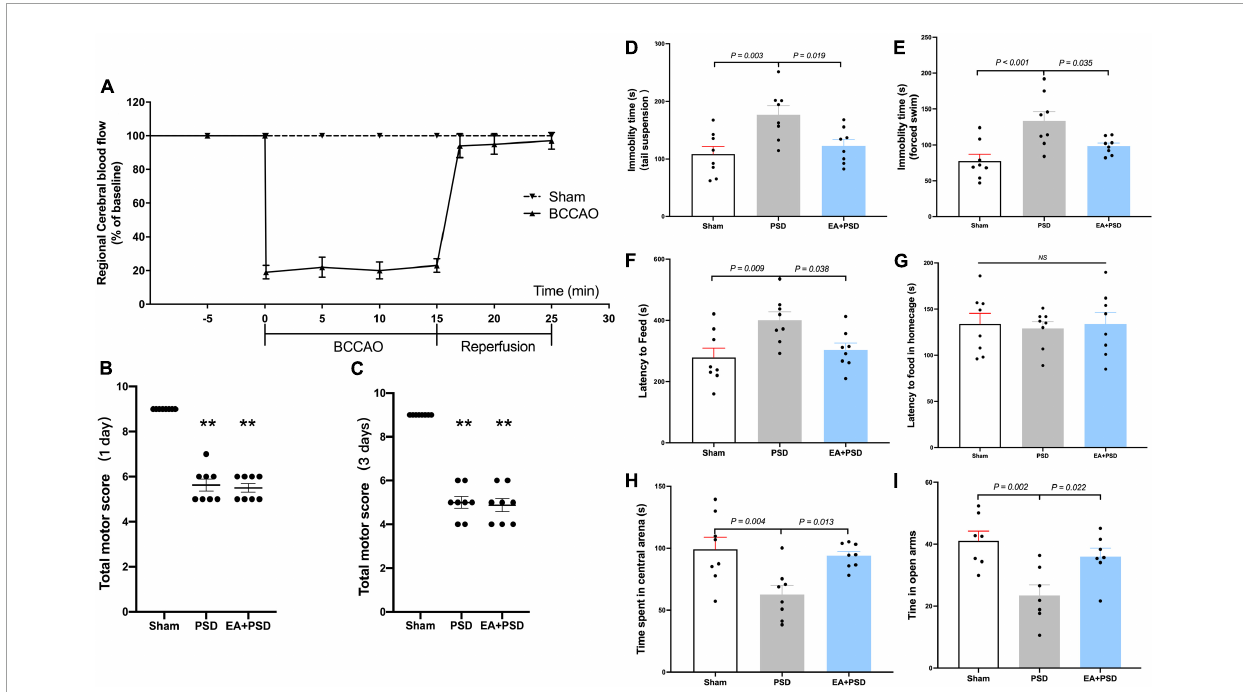
FIGURE1 EA treatment alleviated the depressive-like behavior produced by PSD. (A) Changes in regional cerebral blood flow (rCBF) during BCCAO operation in mice. (B,C) The neuroglial outcome of each group at 1 day and 3 days after reperfusion. ( n = 8, ** P < 0.01 vs. the sham group). (D) The treatment of EA reversed the increased immobility in the TST produced by PSD. (E) The expose of PSD significantly increased the immobility time in FST, whereas EA treatment reversed this increase. (F,G) PSD significantly prolonged the latency to feed during the novel environment in NSF test, while EA treatment prevented this increase. Neither PSD nor EA treatment altered the latency to feed in home cage. (H) PSD elicited a significant reduction in the time spent in the central arena of the open field, whereas EA treatment prevented this reduction. (I) The expose of PSD significantly reduced time spent in open arms in EPM test, while EA treatment reversed this